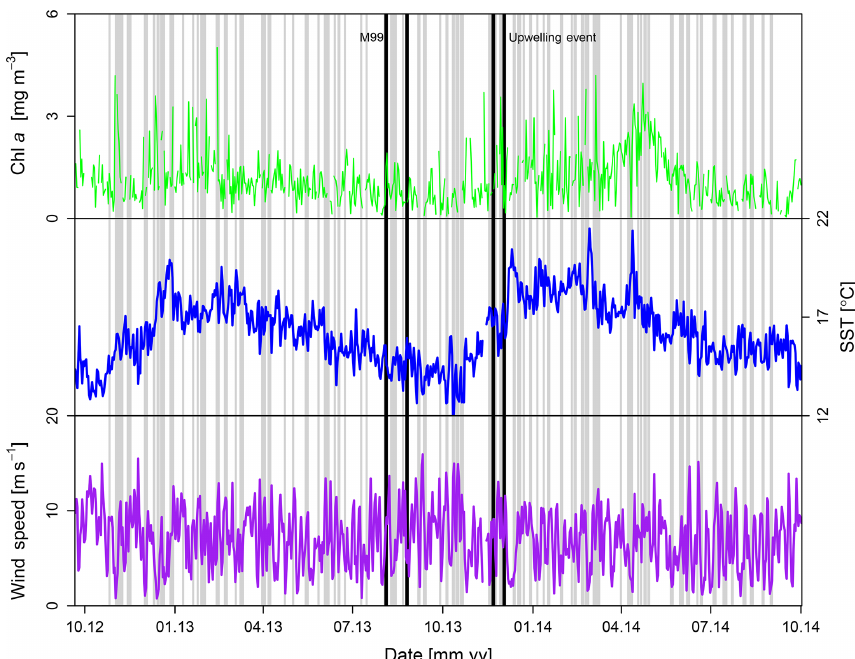
Figure 3. Upwelling events. Surface chlorophyll a , temperature, and 10m wind speed for the Lüderitz domain over the course of the 2-year study period. Days which have been flagged as containing an upwelling event have been shaded. The duration of M99 and the upwelling event discussed in the main text are both demarcated with black rectangles and denoted with a